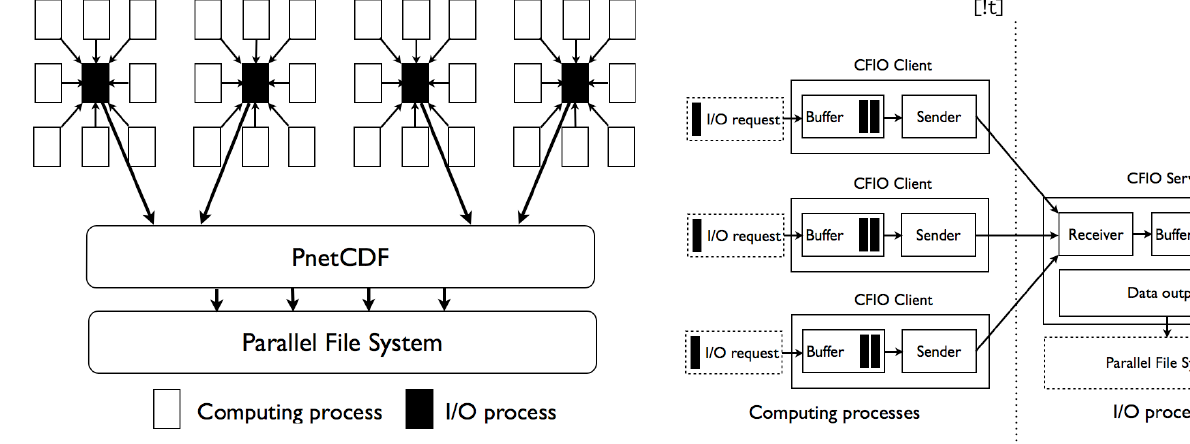
Fig. 2. The schematic diagram of the I/O forwarding technique. A diagram of the I/O forwarding technique is shown in Fig. 2. The computing processes mainly handle the numer-